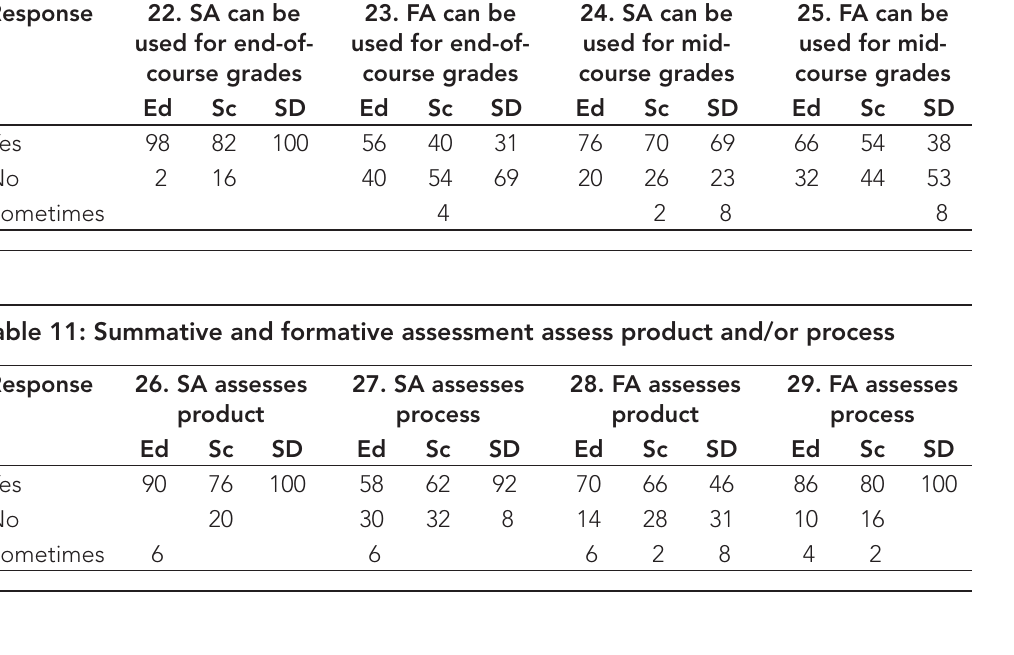
Table 10: Summative and formative assessment can be used for end- or mid-course grades Response